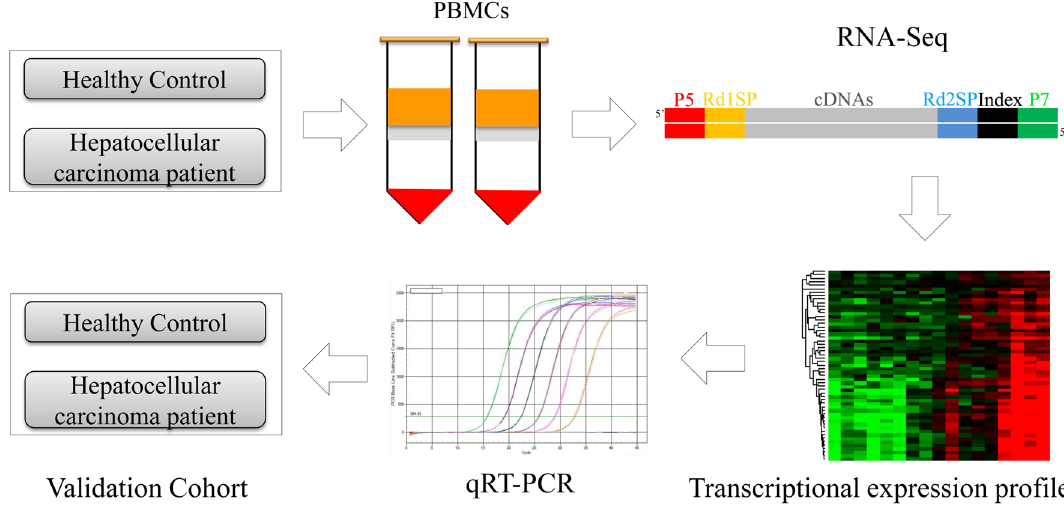
Figure 1. The experiment scheme of the study. It was created using Microsoft office-PowerPoint version 2010, https:// www. micro soft. com/ zh- cn/ micro soft- 365/ micro soft-